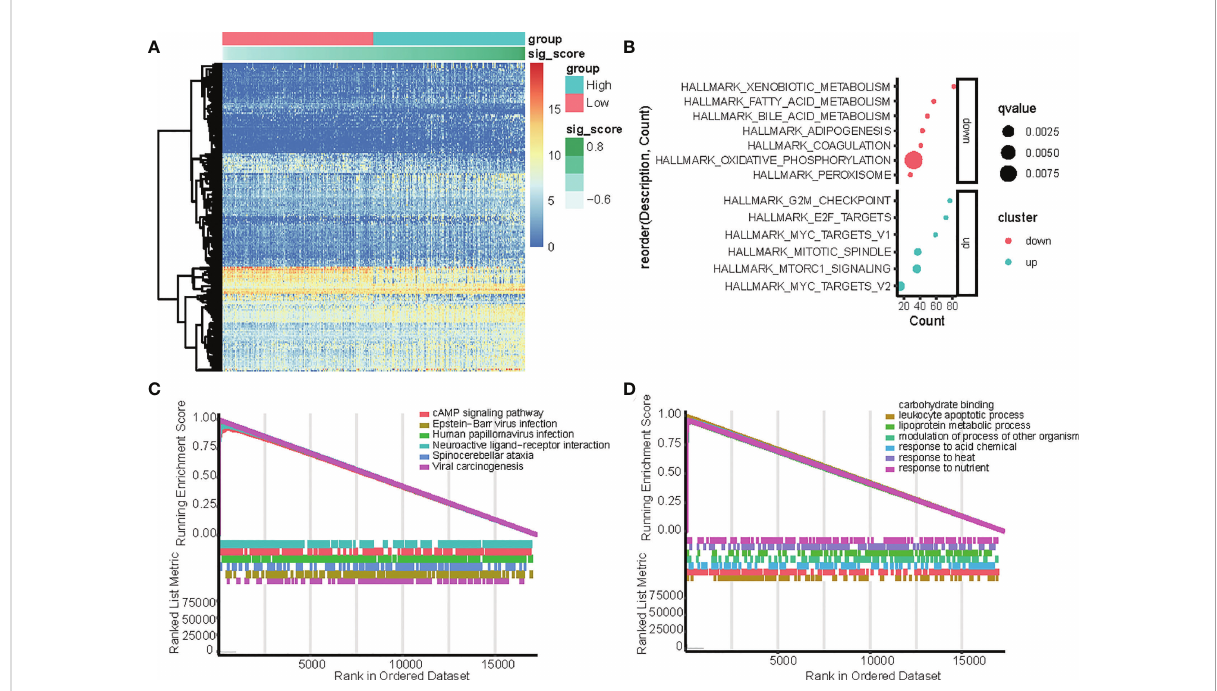
FIGURE 4 Identi fi cation of differentially expressed genes (DEGs) between the high-risk and low-risk score groups in TCGA-LIHC dataset with the cut-off criteria of |logFC|>1 and adj.P <0.05. (A) Heatmap of upregulated and downregulated DEGs in the TCGA-LIHC dataset. (B) Functional enrichment analysis of differentially expressed genes (DEGs) between the high-risk and low-risk groups. (C, D) GSEA analysis in the TCGA dataset according to risk score, (C) hallmark pathway, and (D) KEGG